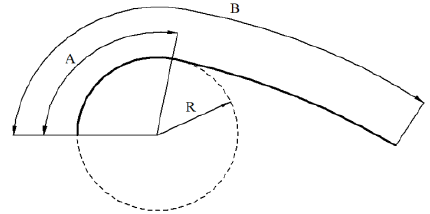
Figure 3. Sivasegaram blade model [18].